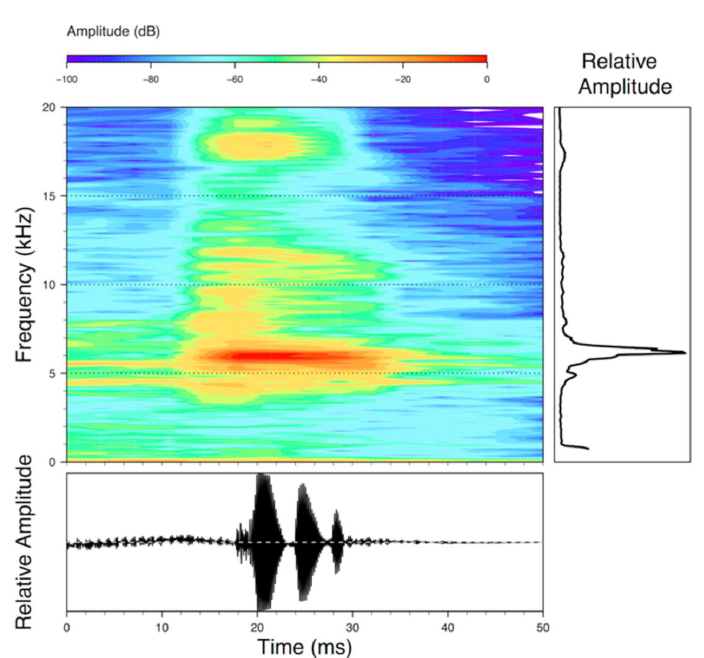
Figure 208. Call of Teratohyla amelie (QCAZ 38779) from a tributary of R í o Lliquino (1.45295 ◦ S; 77.443 ◦ W, 350 m; QCAZ 38779), Provincia Pastaza, Ecuador. Tadpole: Not described.